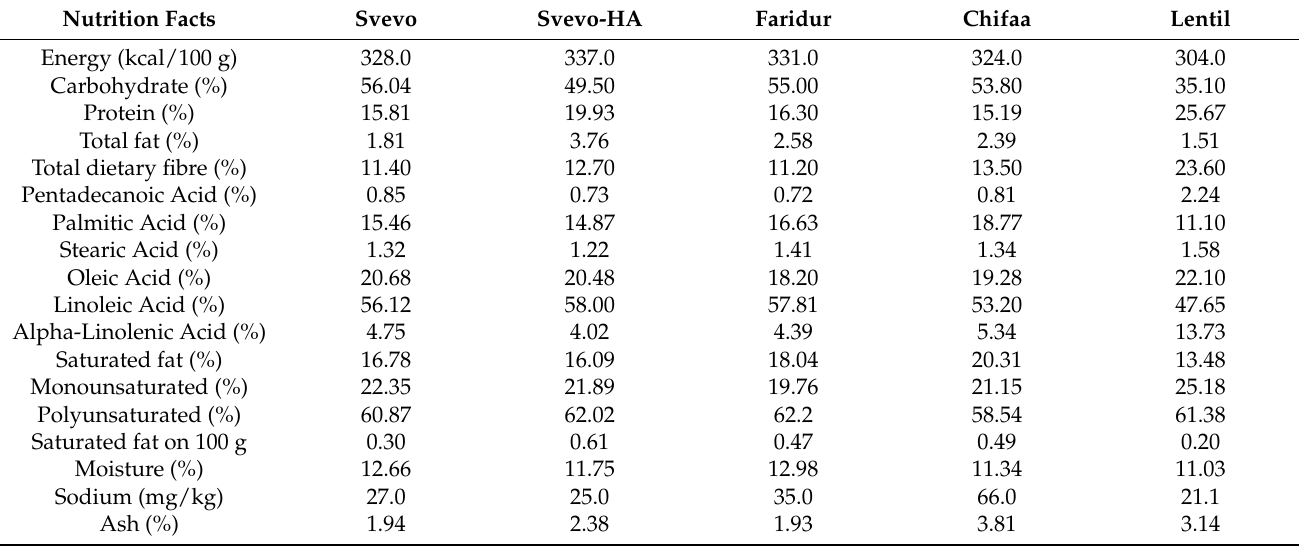
Table A1. Nutrition information of Svevo, Svevo-HA, Faridur, Chifaa and lentil 6002/ILWL118/1-1